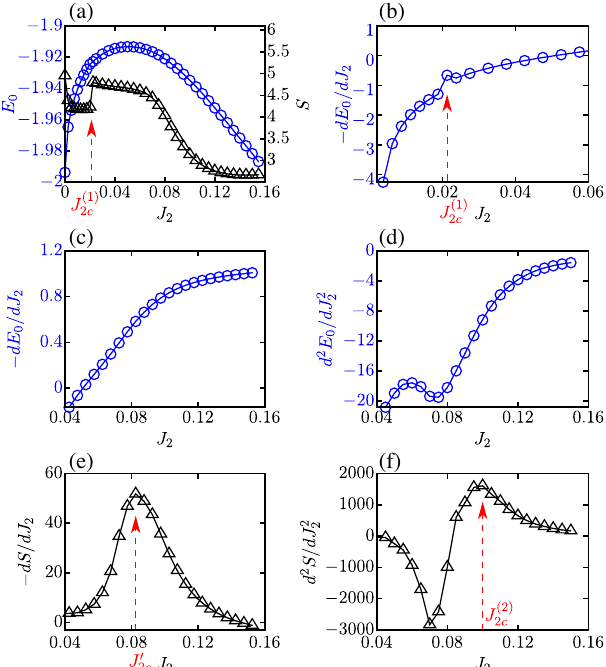
FIG. 6. The energy per site E 0 and entanglement entropy S for various J 2 obtained at fixed J χ ¼ 0 . 05 on a N ¼ 16 × 6